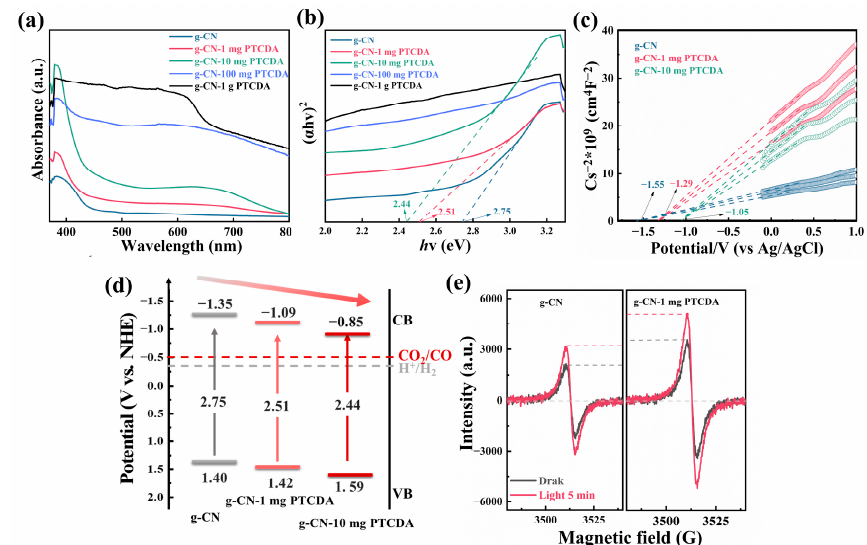
Figure 4. Optical absorption and band positions of g-CN, g-CN-1 mg PTCDA, and g-CN-10 mg PTCDA samples. UV-vis DRS spectra ( a ) and the corresponding Tauc plots ( b ), Mott–Schottky plots ( c ), energy diagrams of the band structure ( d ). EPR spectra of the g-CN and g-CN-1 mg PTCDA at room temperature ( e ).